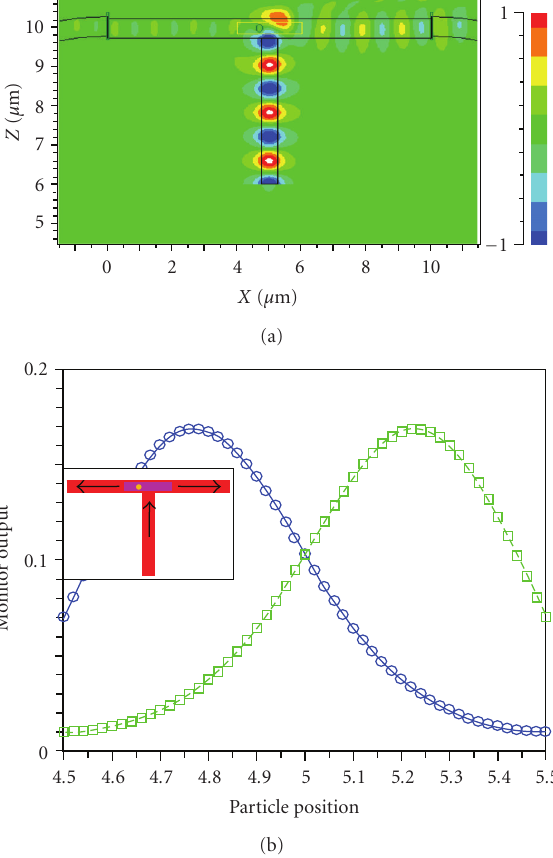
Figure 2: Waveguide-based T-junction. (a) Simulations for switch- ing the output channel in a PMMA waveguide. (b) The same simulation as in Figure 2(a) versus the position of the 100 nm